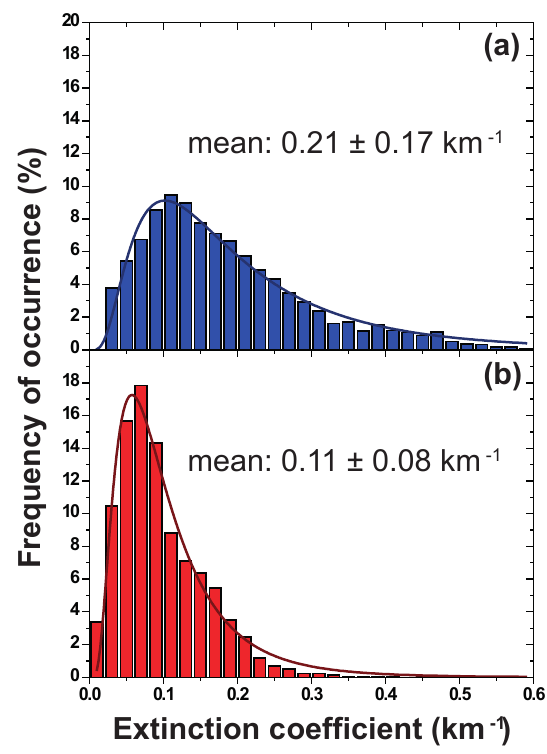
Figure 4. (a) Frequency distribution of ambient 550nm particle ex- tinction coefficient observed with SÆMS at Leipzig from 2009 to 2012; (b) same distribution after correction of the particle water uptake effect, i.e., after normalization of all values to 0% relative humidity by means of Eq. (3) with the parameter for urban aerosol derived from the 4-year SÆMS study. The 2009–2012 mean value and respective SD are given as